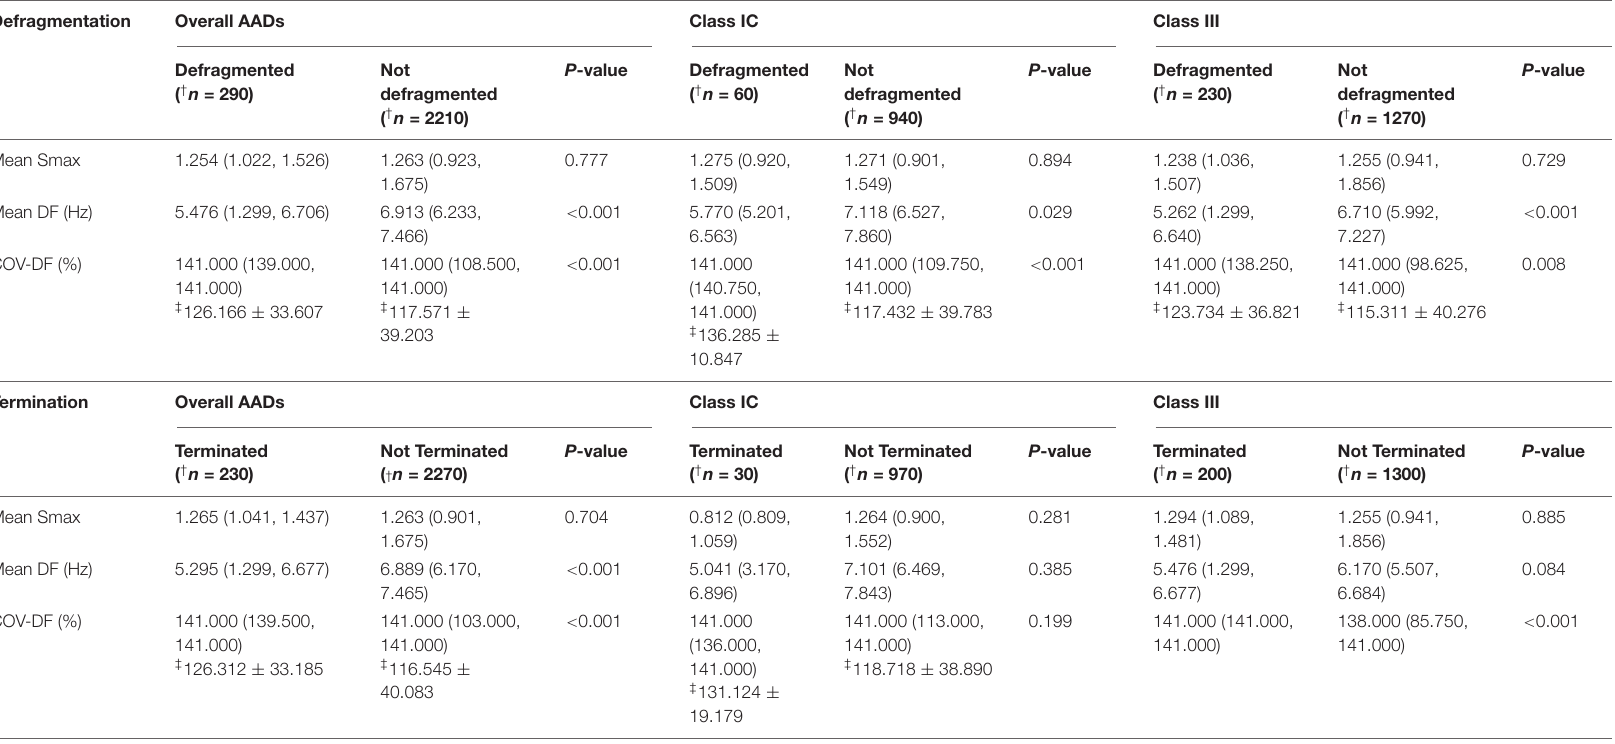
TABLE 4 | Electrophysiological characteristics terminated atrial fibrillation (AF) after antiarrhythmic drugs (AADs).